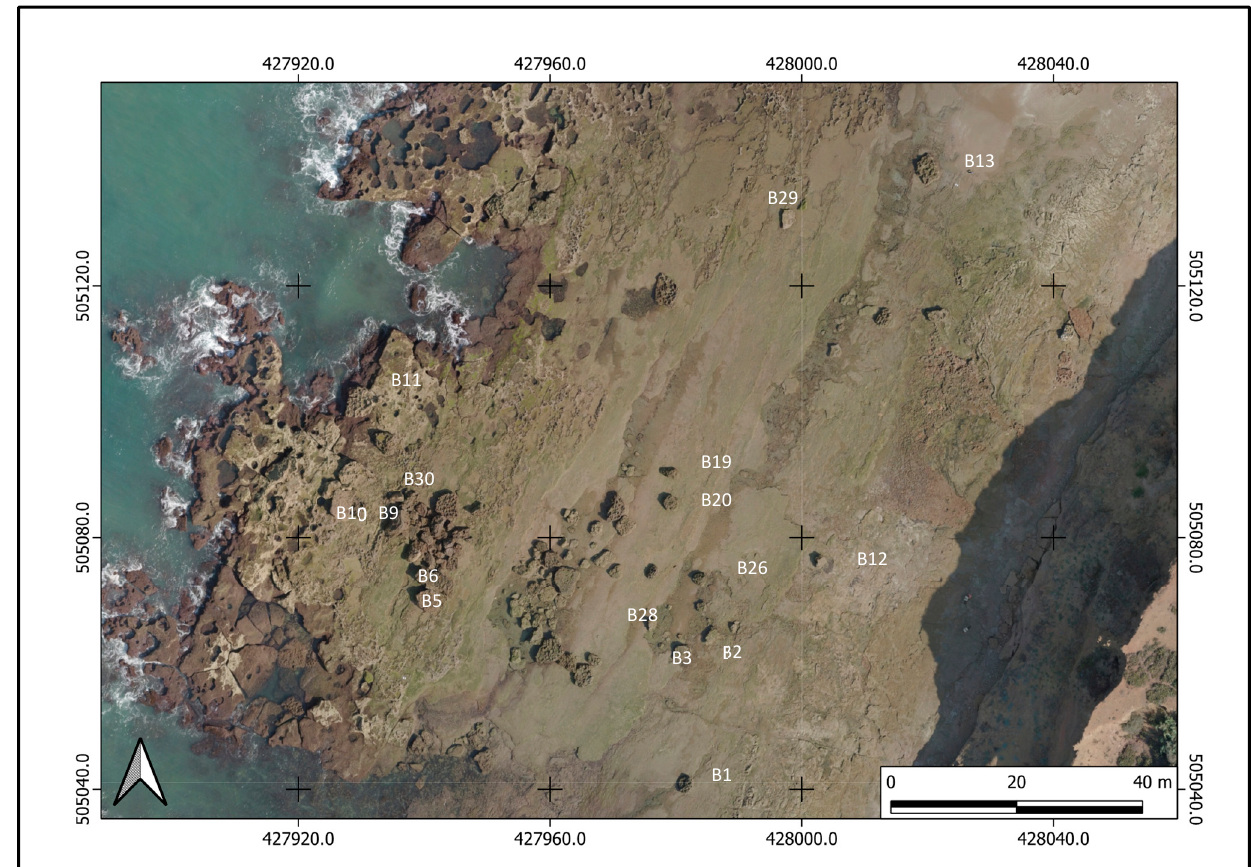
Figure 3. September 2019 orthophotograph showing the spatial distribution of some of the analyzed boulders.